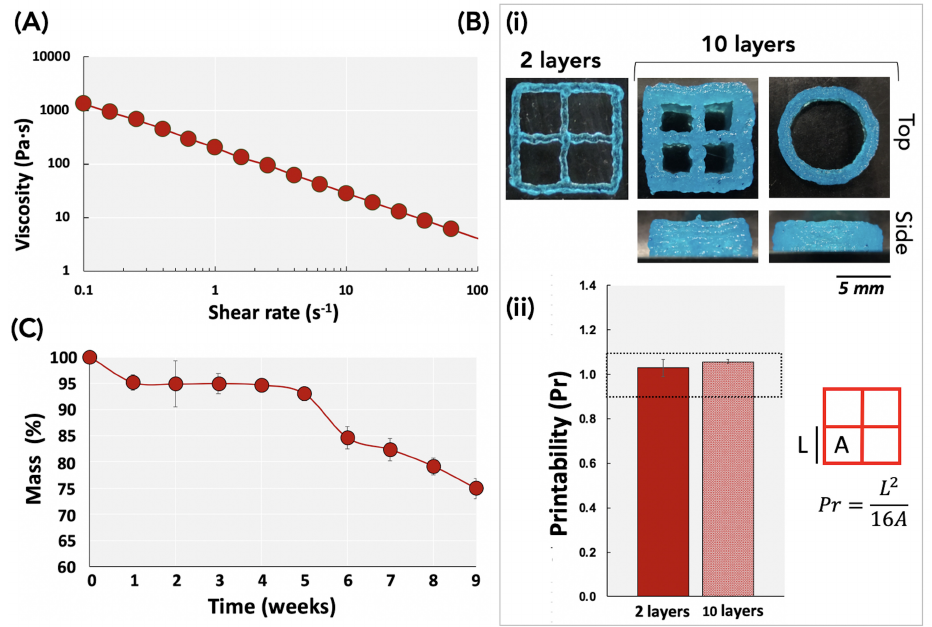
Figure 2. Characterization of the biomaterial ink and in vitro degradation of the 3D-printed scaffolds. ( A ) Viscosity of the ink CH–Gel–GG as a function of the shear rate, measured at 23 °C. ( B ) Evaluation of the printability of CH–Gel–GG ink. ( i ) Qualitative images of 10 mm × 10 mm square and 10 mm circular constructs printed in 2 or 10 layers are presented, viewed from the top and the side. ( ii ) Quantification of the printability (Pr value) of constructs made of 2 layers (full bars) or 10 layers (dotted bars) using the Pr value. ( C ) Degradation profile of CH–Gel–GG constructs in lysozyme at 37 °C for 9